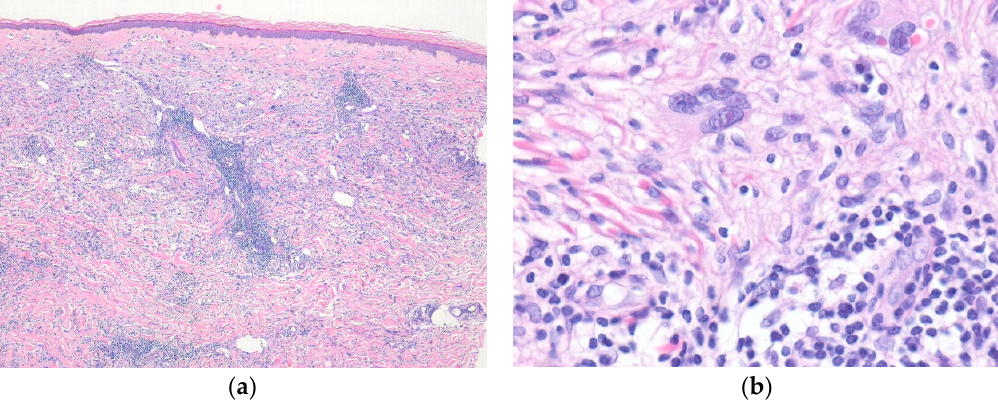
Figure 1. Myxoinflammatory fibroblastic sarcoma. ( a ) A poorly defined lesion in dermis shows prominent inflammatory cell infiltrates and scattered mono- or multinucleated pleomorphic cells; ( b ) Occasional pleomorphic multinucleated giant cells with viral inclusion-like nucleoli are seen in the background of inflammatory cell infiltrates (H&E stain, original magnifications 40× ( a ) and 200× ( b